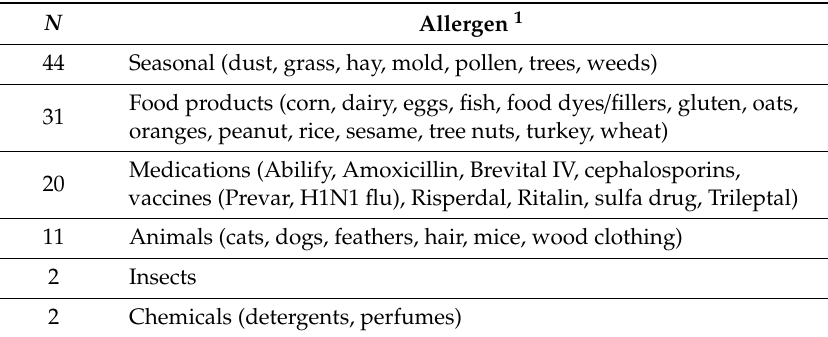
Table 11. Allergens reported in FXS study